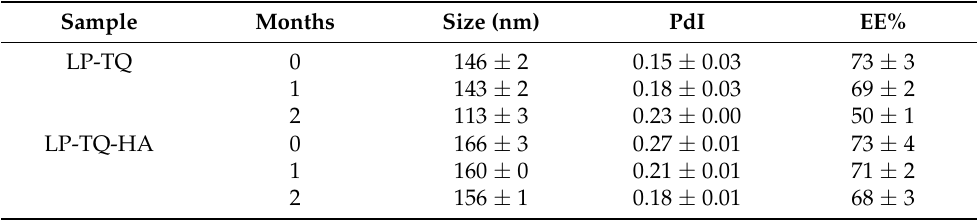
Table 5. Storage stability test of TQ-loaded liposomes (LP-TQ) and TQ-loaded liposomes coated